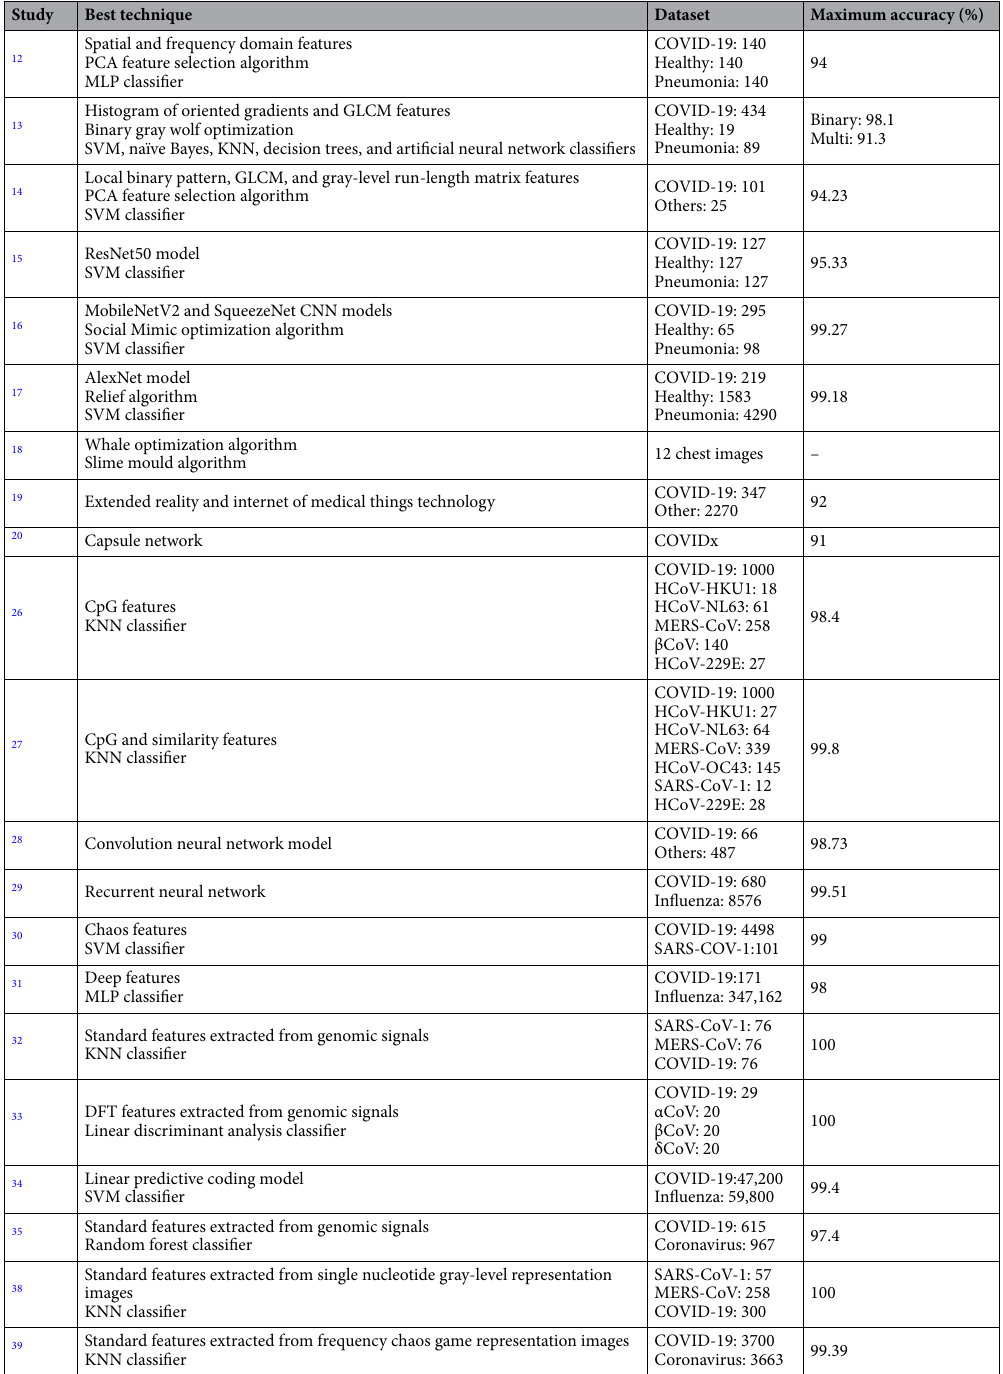
Table 1. Results of the literature review. PCA principal component analysis, MLP multilayer perceptron classifier, GLCM gray level co-occurrence matrix, SVM support vector machine, KNN K-nearest neighbors, DFT discrete Fourier